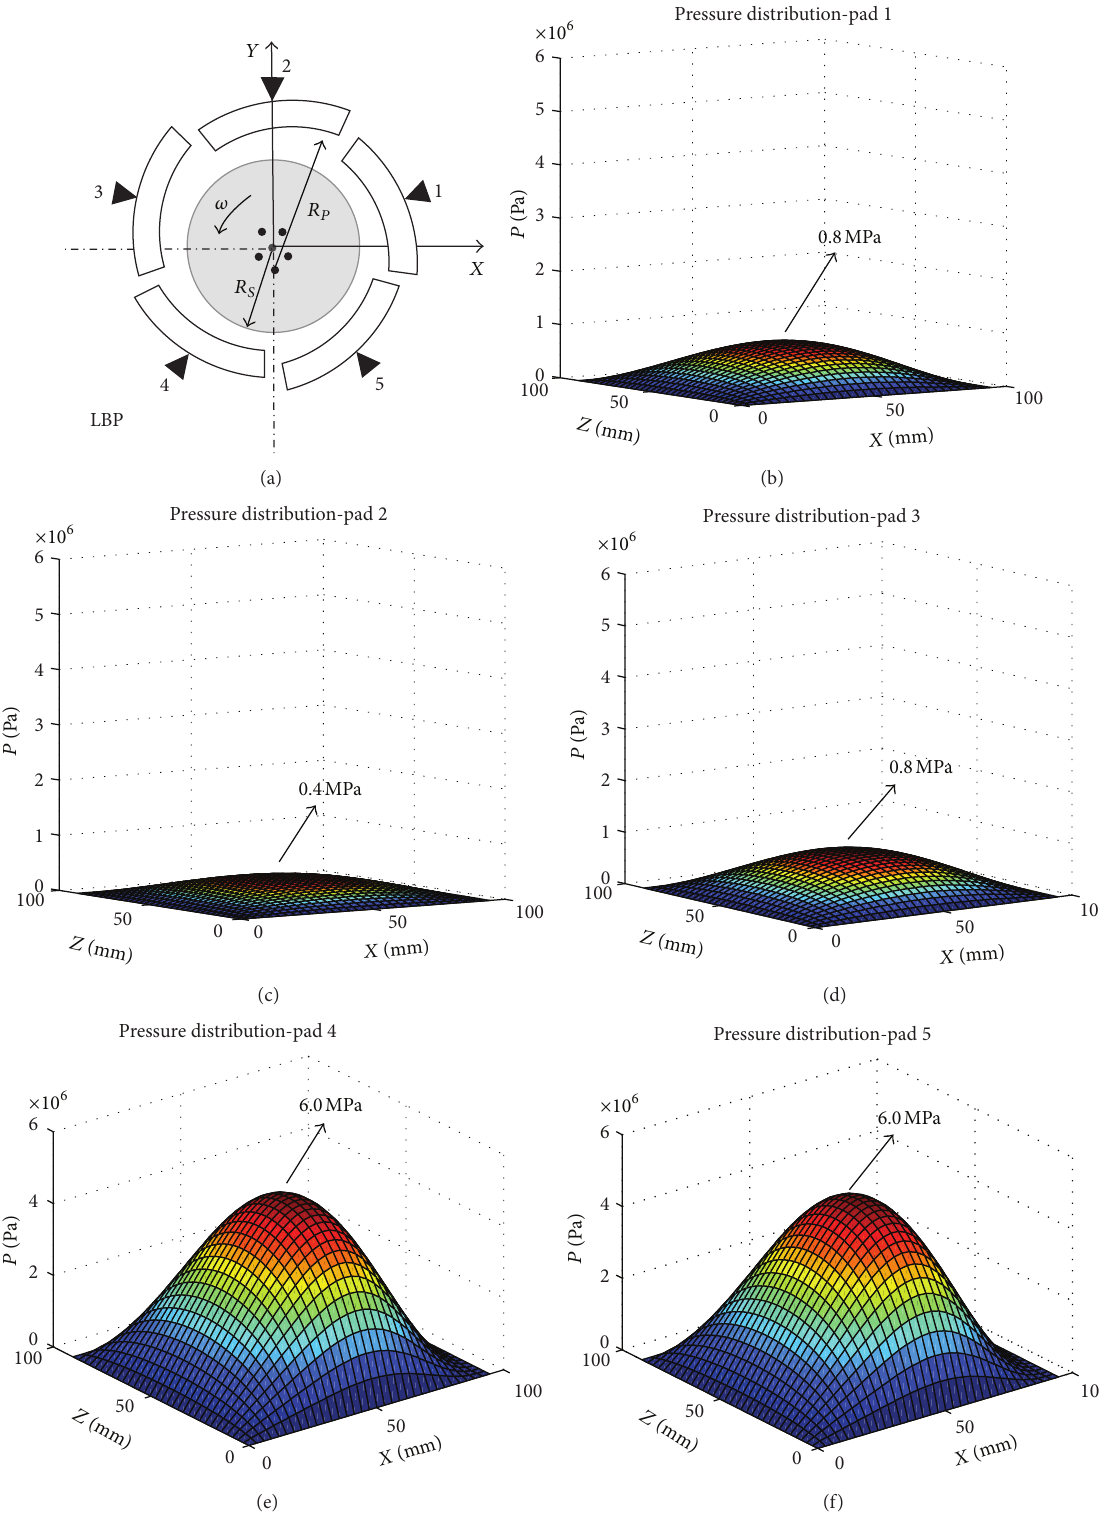
Figure 12: Pressure distribution on the pads obtained from the lower radial clearance and the maximum rotational speed: (a) bearing configuration; (b) pad 1; (c) pad 2; (d) pad 3; (e) pad 4; (f) pad